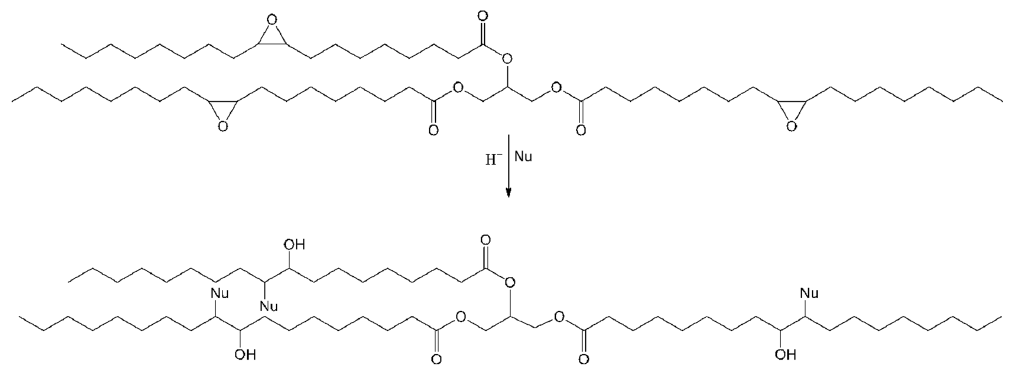
Figure 3 . Ring-opening reaction of epoxides with a nucleophile (Nu).